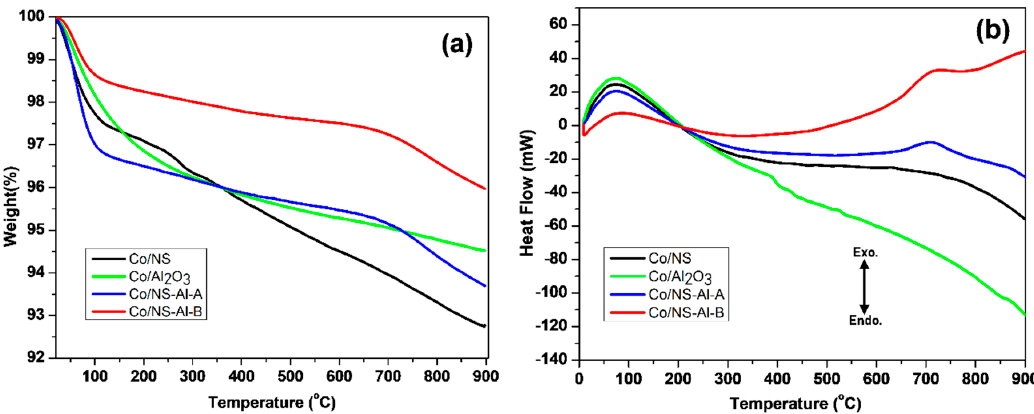
Figure 2. ( a ) Thermogravimetric analysis (TGA) and ( b ) DTA thermograms of the calcined Co/NS, Co/Al 2 O 3 , Co/NS-Al-A and Co/NS-Al-B catalysts.